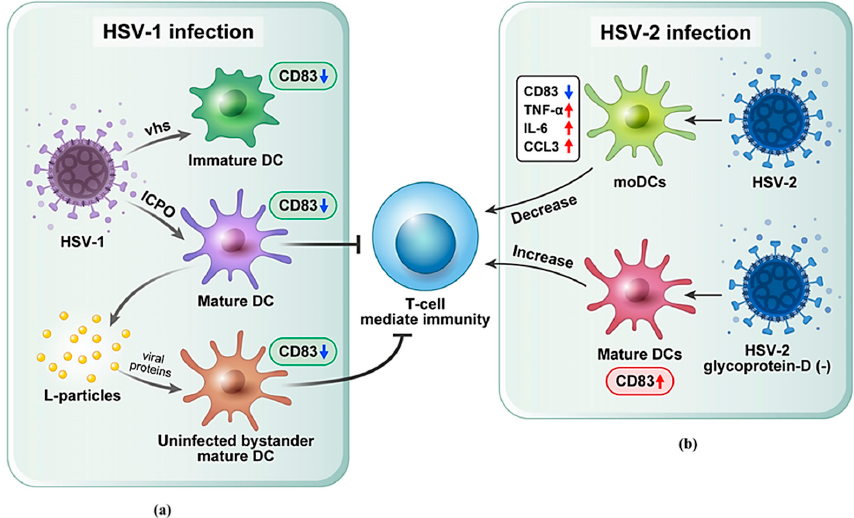
Figure 2. Correlation between CD83 and HSV. ( a ) HSV-1 proteins vhs and ICP0 degraded the CD83 on iDC and matDC, respectively. Uninfected-bystander matDCs showed a significant CD83 reduction because L-particles are released from infected matDCs. Uninfected bystander matDCs and infected matDCs prevent T cell activation. ( b ) HSV-2 infection on moDCs reduced CD83 levels and enhanced cytokine and protein levels (TNF- α , IL-6, CCL3), further attenuating the T cell responses. When glycoprotein-D deleted HSV-2 virus is exposed to DCs, T cell stimulation is enhanced. HSV, Herpes simplex virus; vhs, host-shutoff protein; ICPO, infected-cell protein-0; moDCs,